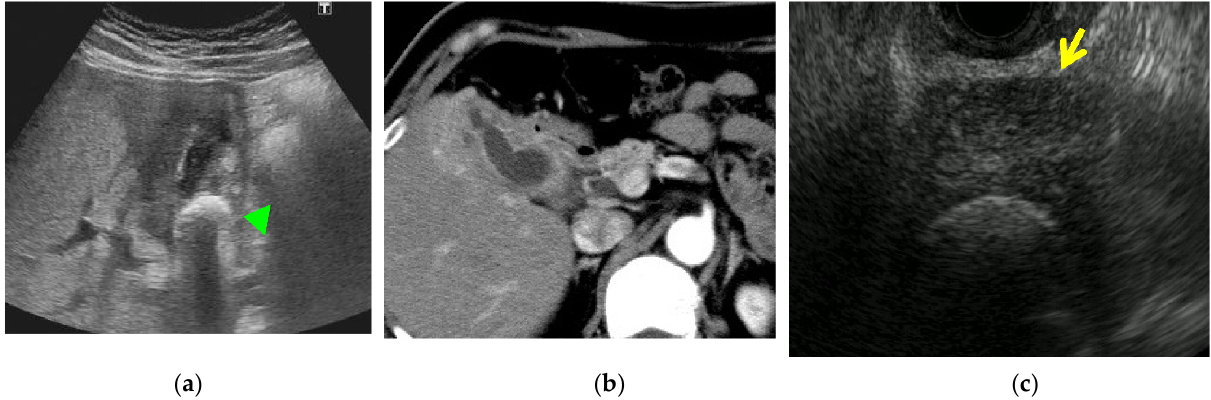
Figure 5. Xanthogranulomatous cholecystitis. ( a ) Abdominal ultrasonography: Wall thickening around the entire gallblad- der and gall stone in the neck (arrow head). ( b ) Contrast-enhanced computed tomography: Marked wall thickening and poorly marginated border with liver parenchyma. ( c ) Endoscopic ultrasonography (EUS): Marked wall thickening (arrow).